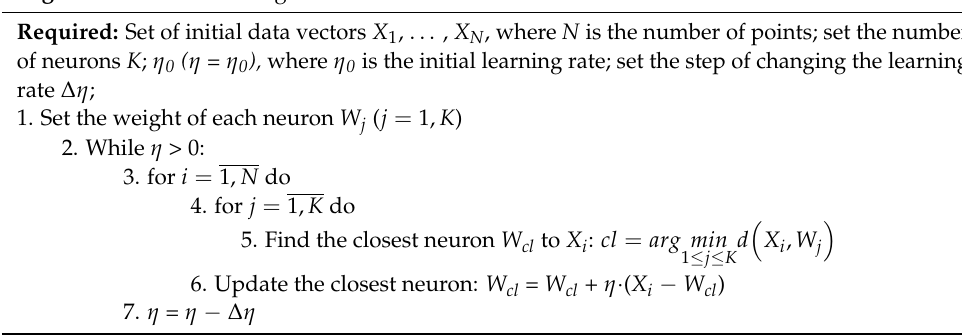
Algorithm 1. Basic SCL